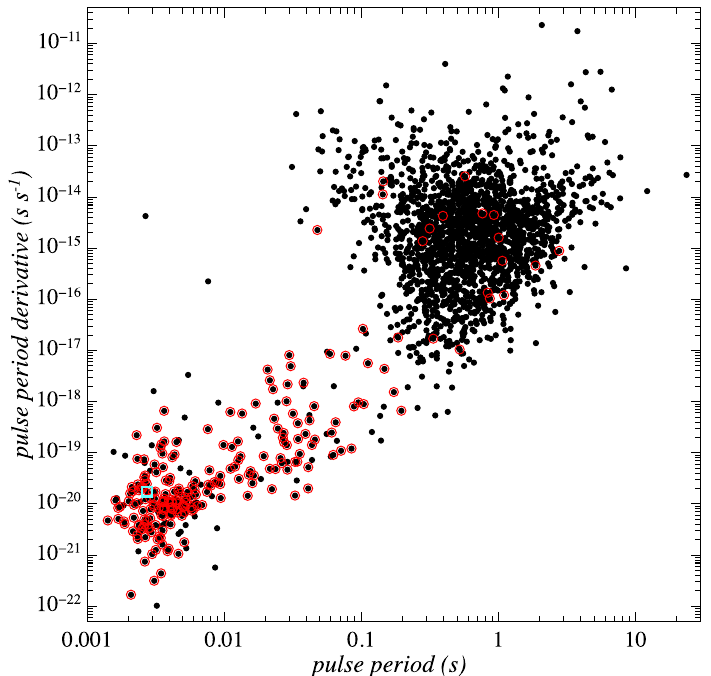
Figure 1. Period-period derivative diagram for radio pulsars. Pulsars in binary systems are marked by red circles. The pulsar in a stellar triple system is marked with a light blue square. Data have been taken from